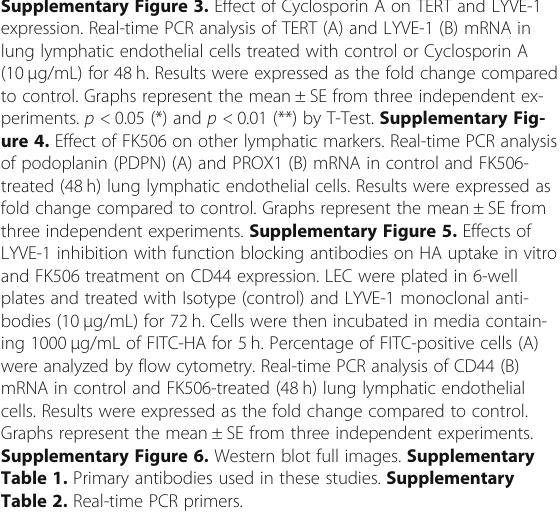
Supplementary Figure 3. Effect of Cyclosporin A on TERT and LYVE-1 expression. Real-time PCR analysis of TERT (A) and LYVE-1 (B) mRNA in lung lymphatic endothelial cells treated with control or Cyclosporin A (10 μ g/mL) for 48h. Results were expressed as the fold change compared to control. Graphs represent the mean ± SE from three independent ex- periments. p < 0.05 (*) and p < 0.01 (**) by T-Test. Supplementary Fig- ure 4. Effect of FK506 on other lymphatic markers. Real-time PCR analysis of podoplanin (PDPN) (A) and PROX1 (B) mRNA in control and FK506-